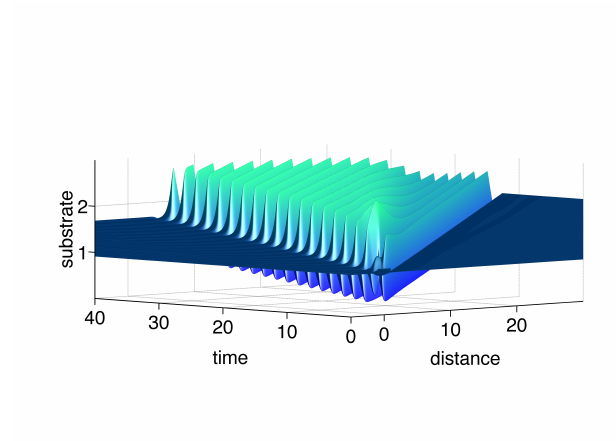
Figure 1. Pattern found for a diffusion system with convection and limit-cycle reaction kinetics (1). The initial disturbance propagates and becomes pronounced, forming a regular pattern with aligned oscillations. The propagation is linear, forming a V-shape. This is a numerical solution using NAG D03PCF, plotting species u with µ = 1 . 1 , D 1 = 0 . 01 , D 2 = 0 . 01 , ρ = 1 . The reactants are initially at steady state: ( u, v ) = (1 /µ, µ ) , with a small disturbance at x = 0 . The boundaries are held at zero derivative: u x , v x = 0